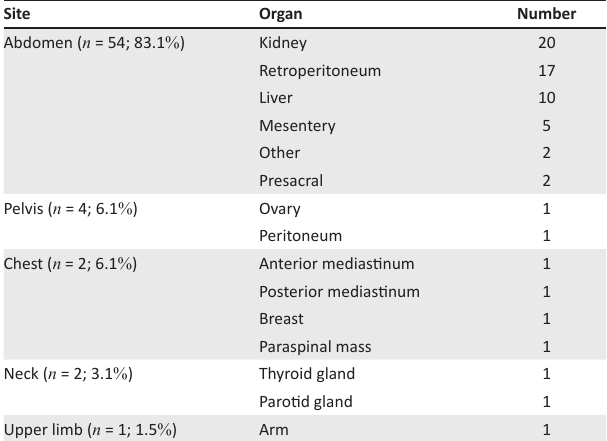
TABLE 2: Anatomical location.